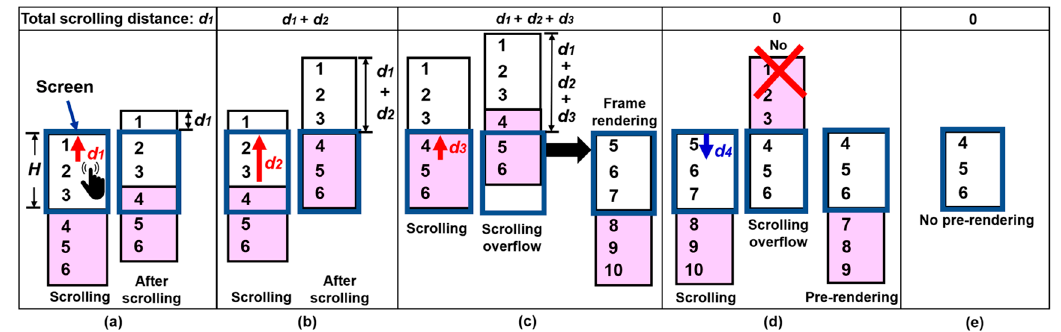
Figure 5. Policy of deciding whether to render or reuse an exFrame: ( a ) up-scrolling by d 1 ; ( b ) up-scrolling by d 2 ; ( c ) up- scrolling overflow; ( d ) down-scrolling overflow; ( e ) frame rendering in down-scrolling overflow.